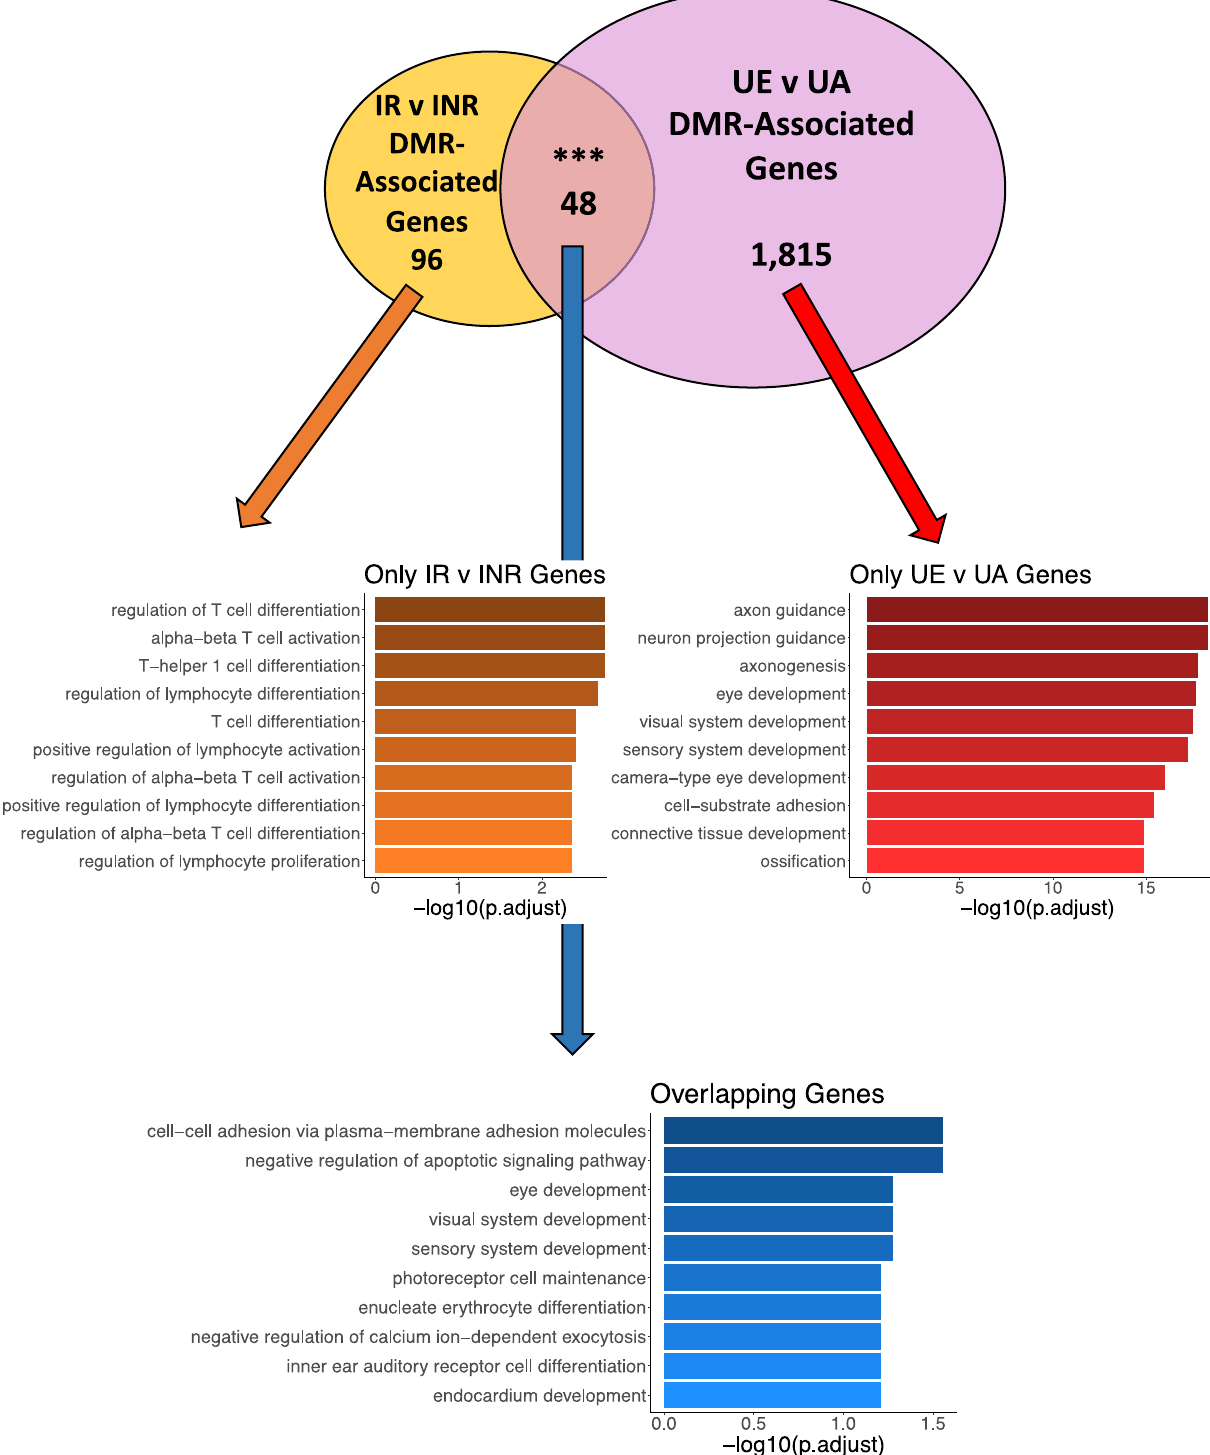
Fig. 6 Distinct processes are affected in embryonic and regenerated adult RGCs. A Venn diagram shows the overlap ( N = 48) between genes containing DMRs in the injured/regenerated (IR) and injured/non-regenerated (INR) samples compared to the uninjured adult (UA) and uninjured embryonic (UE) samples. Dot plots for each unique set of genes are depicted below the Venn diagram. The color of the dots represents the adjusted P value from the enrichment analysis. The size of the dots represents the number of genes associated with each ontological term ( y axis). The x axis depicts the percent of DMR-associated genes contained among all the genes associated with each ontological